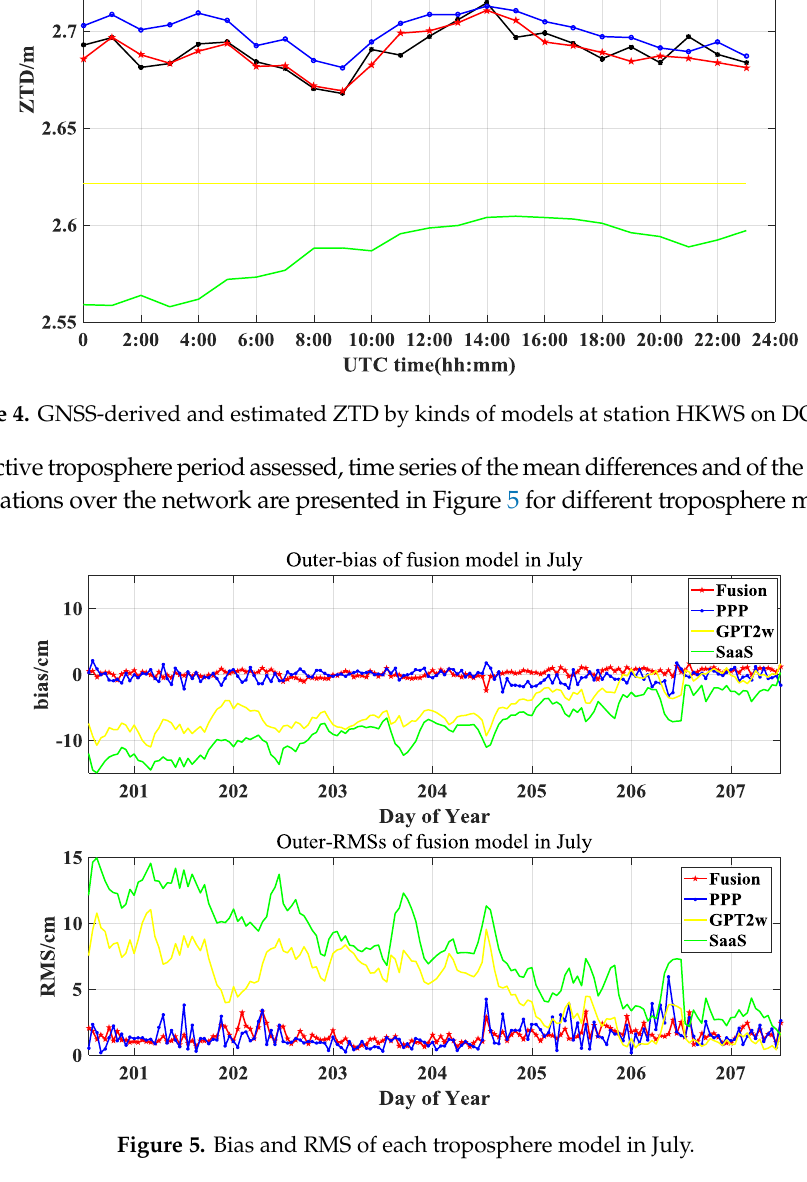
Figure 5. Bias and RMS of each troposphere model in July.